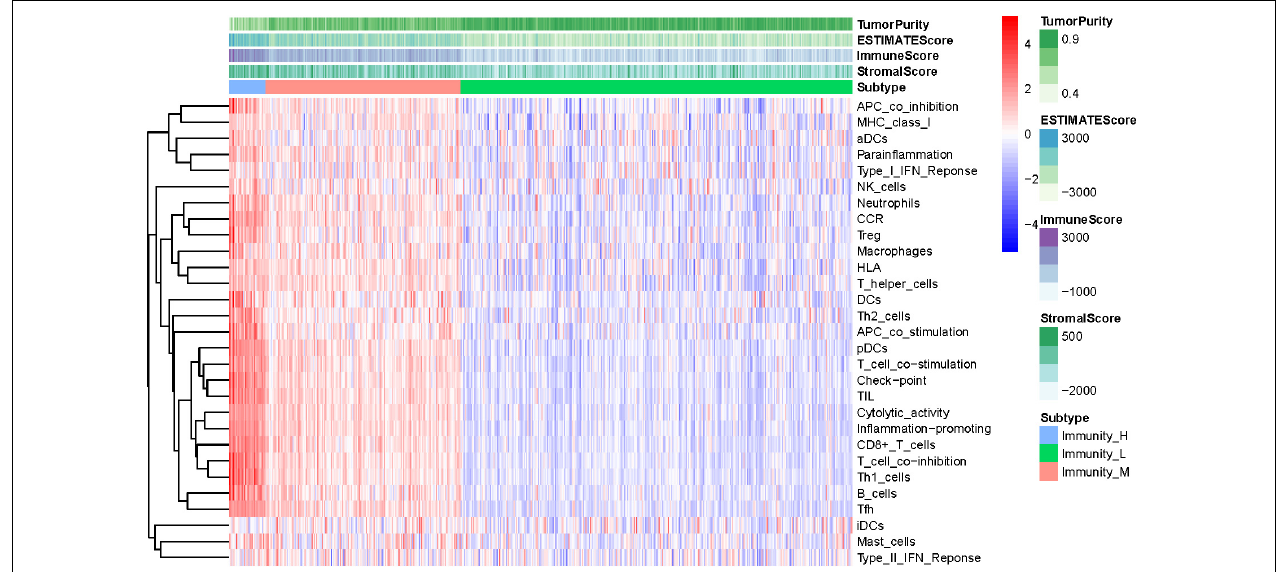
FIGURE 2 | Hierarchical clustering of UCEC patients. Three distinct immune infiltration clusters, termed Immunity_H, Immunity_M and Immunity_L were defined with the help of ssGSEA scores of 29 immune signatures from TCGA database. The immune cells were highly expressed in the Immunity_H, and the low expressed in the Immunity_L group. Tumor purity, ESTIMATE Score, Immune Score and Stromal Score are shown in the above panel. Immunity_H (Immunity High), Immunity_M (Immunity Medium), and Immunity_L (Immunity Low) (The reference gene list can be obtained in the Supplementary Material A ).